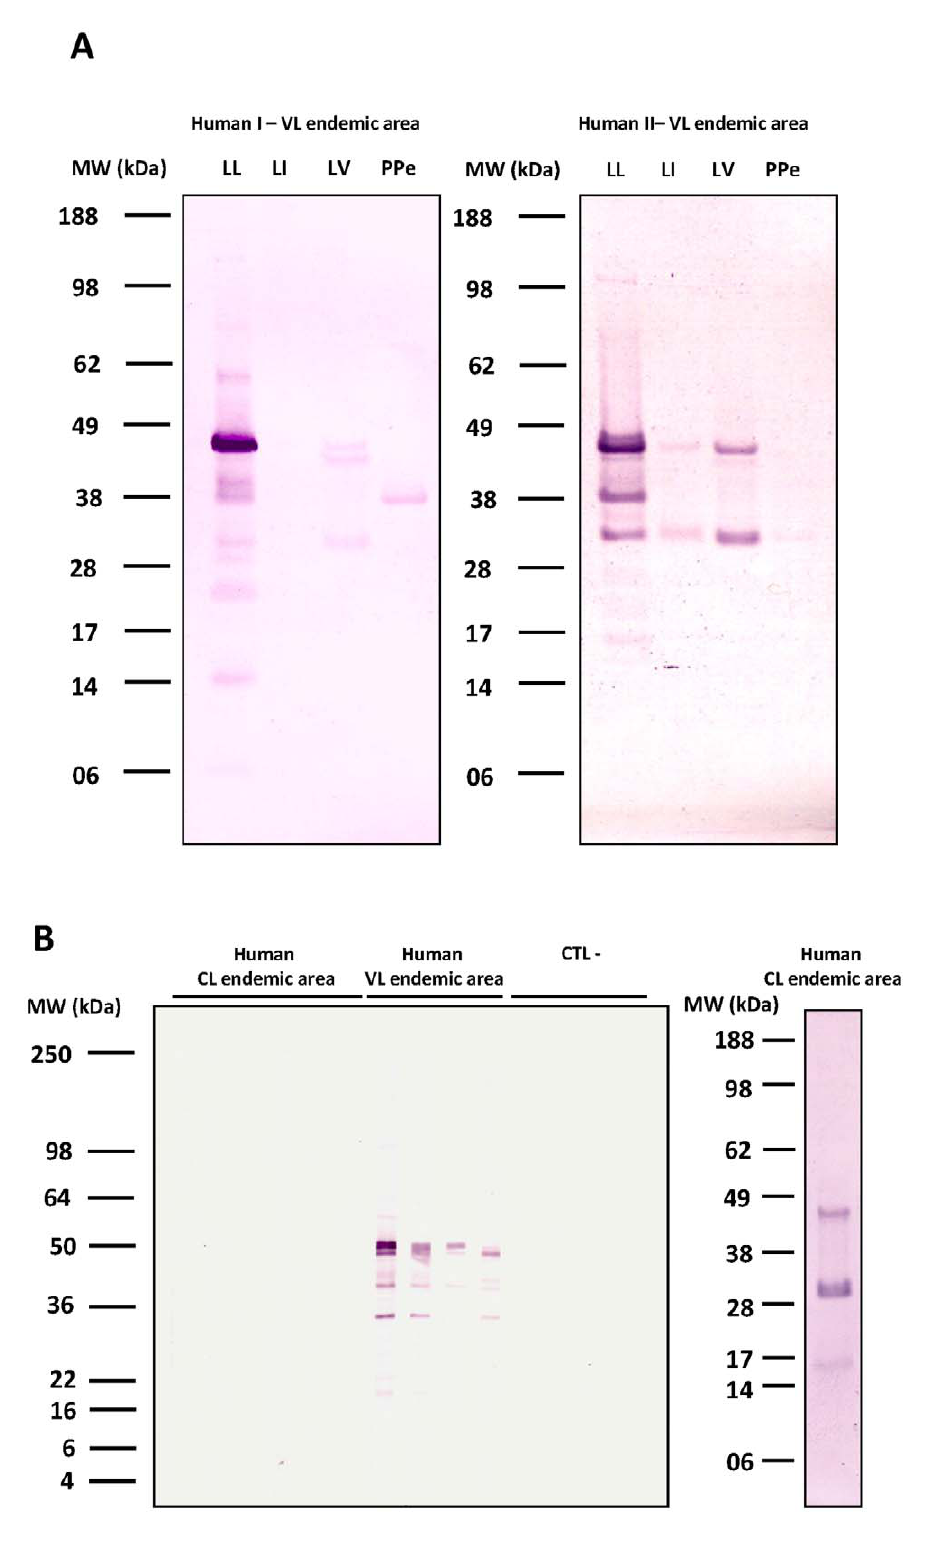
Figure 2. Detection of salivary proteins from different species of sand flies by Western Blot. A , Two representative human sera from Sa ˜ o Luis, a VL- endemic area where Lutzomyia longipalpis predominates, were screened against salivary proteins from Lu. longipalpis (LL), Lu. intermedia (LI), Lu. verrucarum (LV), and Phlebotomus perniciosus (PPe). B , Western blot analysis of salivary proteins from Lu. longipalpis using human sera from Canoa, a cutaneous leishmaniasis endemic area where Lu. intermedia predominates (CL endemic area; left bottom panel), or from Sa˜o Luis where Lu. longipalpis predominates (VL endemic area). Sera from individuals from a non-endemic area were used as negative controls (CTL–). The profile of salivary proteins from Lu. intermedia recognized by a representative human serum (out of six tested ) from the Canoa endemic area (CL endemic area; right bottom panel).